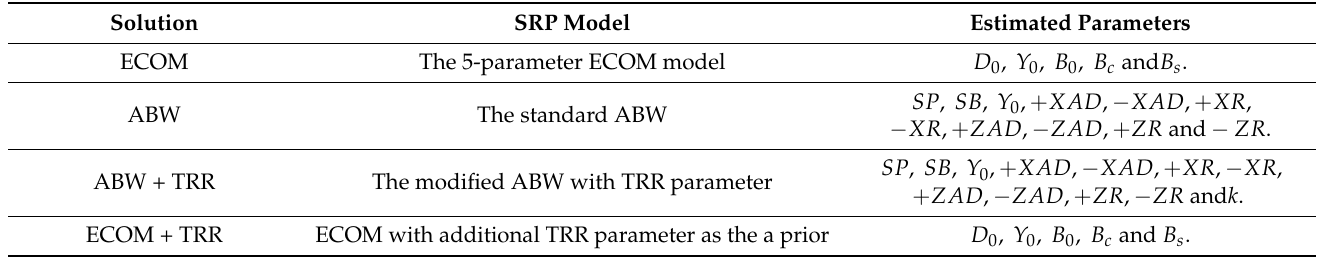
Table 3. Solutions with the SRP model used and estimated